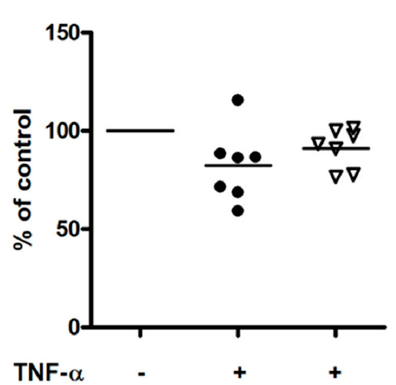
Figure 2. ( A ) IL-10 enhances entry of full-length EBOV Kikwit GP pseudotyped VLPs in MDM from multiple donors ( n = 25). MDM were pre-incubated with IL10 (20 ng/mL) for 48 h prior to infection. The cells were processed and the EBOV Kikwit VLP (solid diamonds) entry/fusion was analyzed by Laser Scanning Cytometry as described in the Materials and Methods and Figure 1. BlaM-containing virus particles, pseudotyped with influenza HA/NA (white triangles), served as controls. The levels of virus entry in mock-treated MDM (with an equivalent volume of cytokine re-suspension buffer) were assumed to be 100%. The graph summarizes data from multiple experiments and includes the results for the IL-10 effect on EBOV Kikwit VLP entry at a concentration of 20 ng/mL in the MDM of